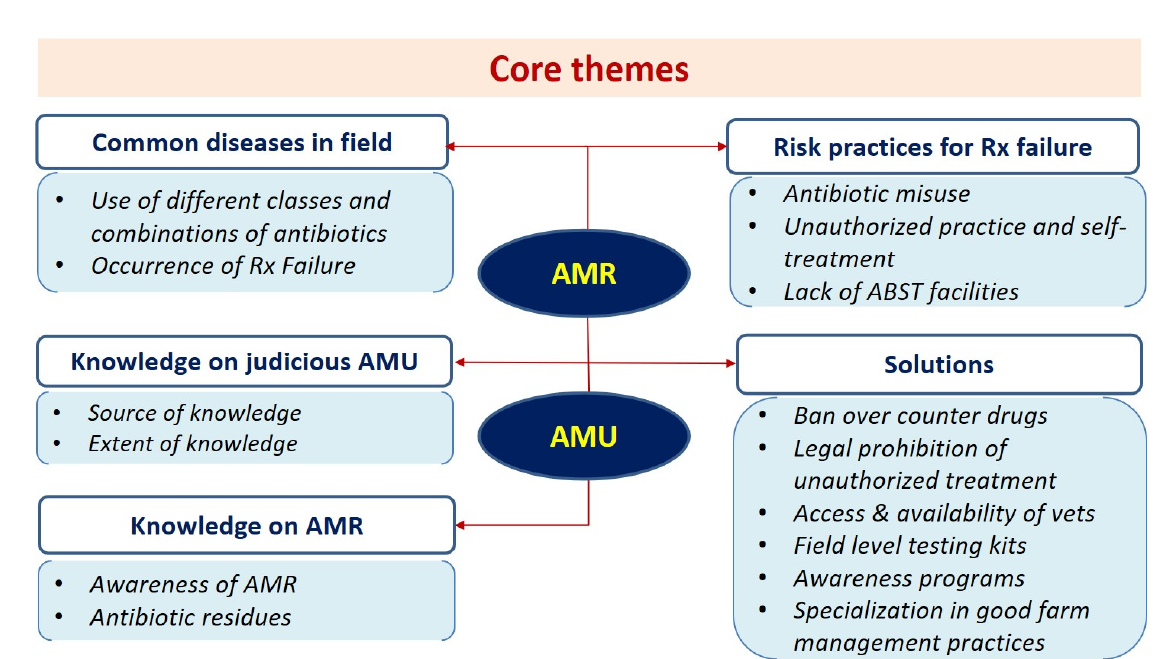
Figure 1. Core themes from focus group discussions and key informant interviews. (Used abbreviations: Rx = veterinary treatment; ABST = antibiotic sensitivity test; AMU = antimicrobial usage; AMR = antimicrobial resistance). Table 1. The demographic characteristics of the study participants.